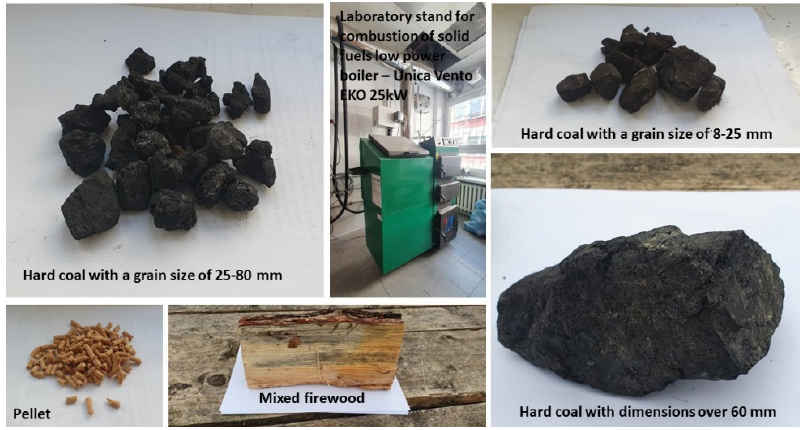
Figure 1. Schematic of solid fuel combustion experiment.